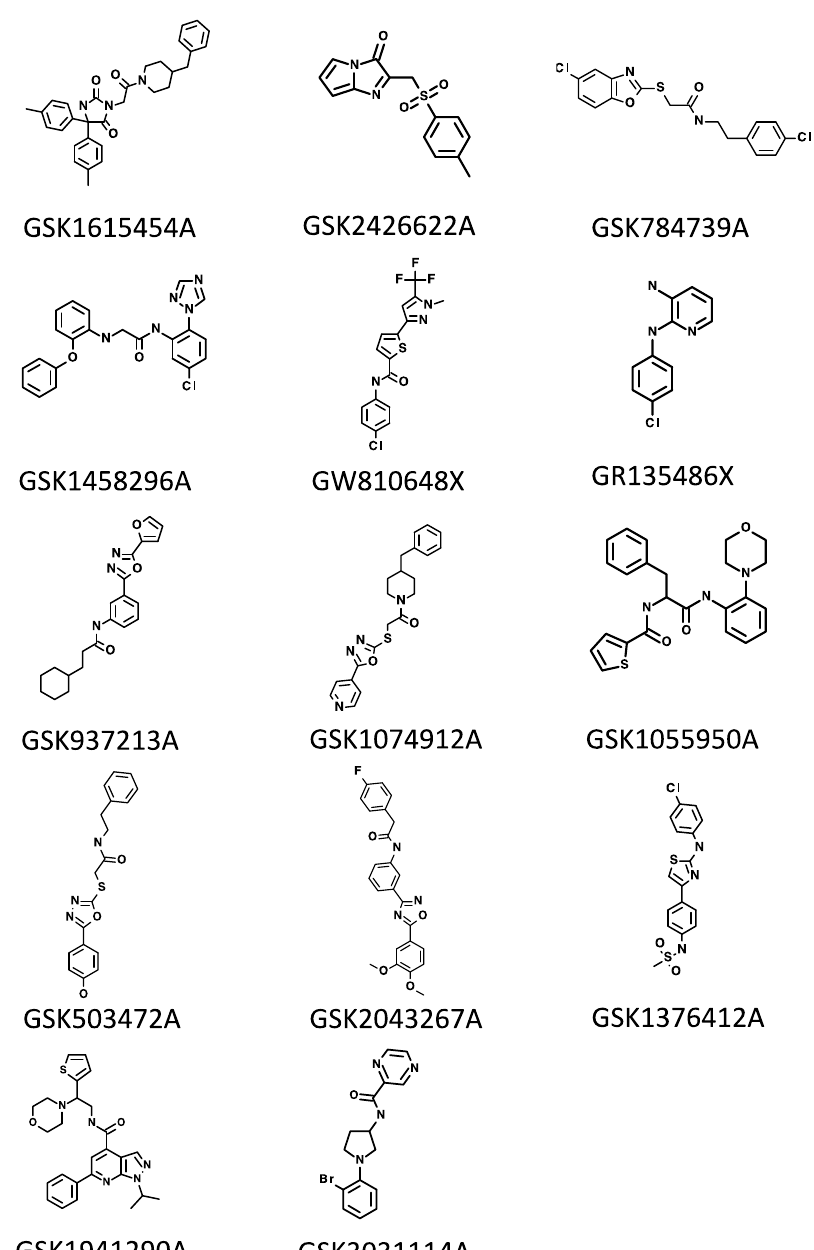
Figure 2. Structures of compounds. Formulas were converted to structures using the PubChem structure tool (https://pubchem.ncbi.nlm.nih.gov//edit3/index.html, accessed on 15 June 2022).